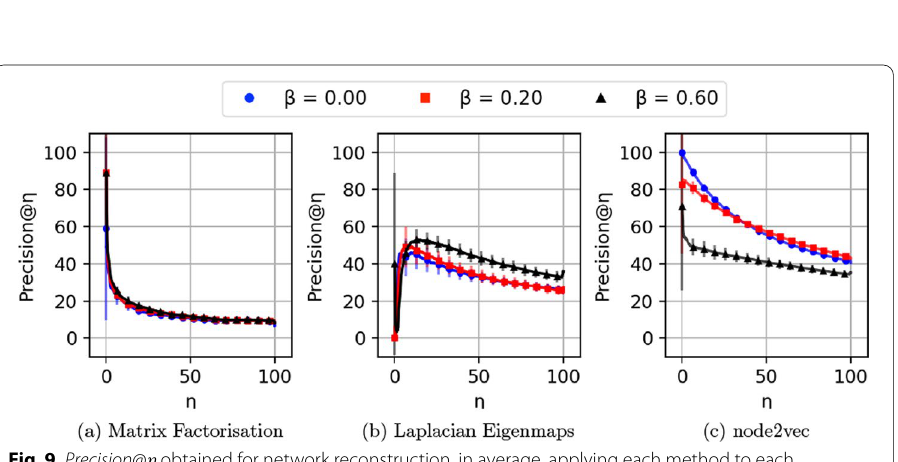
Fig. 9 Precision @ η obtained for network reconstruction, in average, applying each method to each generated data set ( γ = 3.00 ). η is expressed in percentage